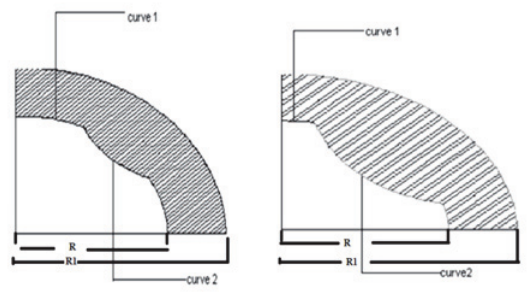
Fig. 3. First replicas of rose petal and star shape grain configuration